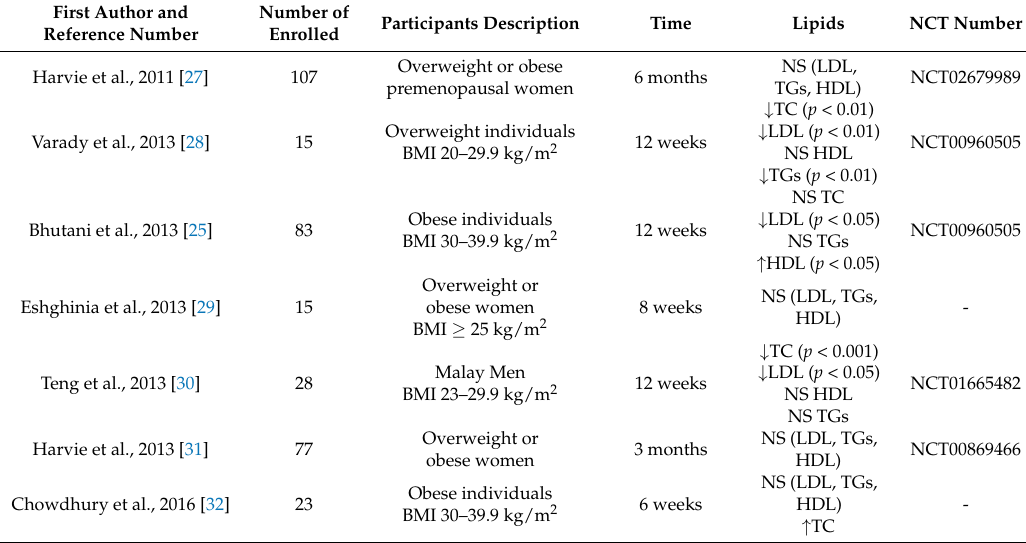
Table 2. Impact of intermittent fasting on lipid